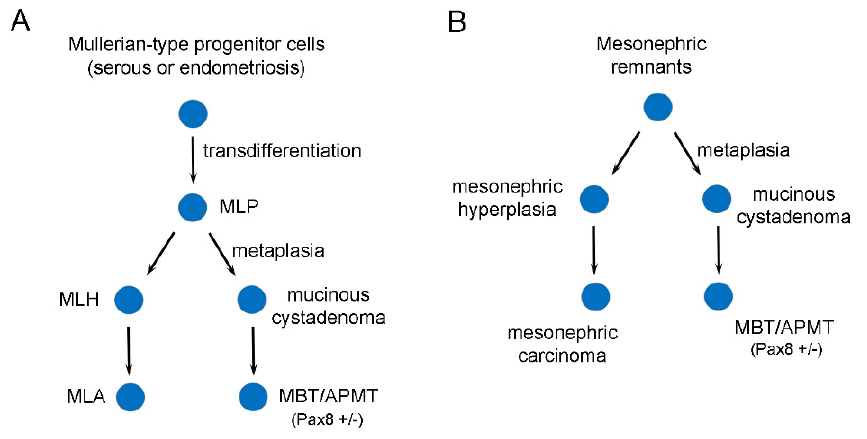
Figure 4. Histopathogenic models for mixed mesonephric and mucinous tumors in the ovary. ( A ) A model of Müllerian/mesonephric-like origin. ( B ) A model of Wolffian/mesonephric origin. MBT/APMT: mucinous borderline tumor/atypical proliferative mucinous tumor; MLA: mesonephric-like adenocarcinoma; MLH: mesonephric-like hyperplasia; MLP: mesonephric-like